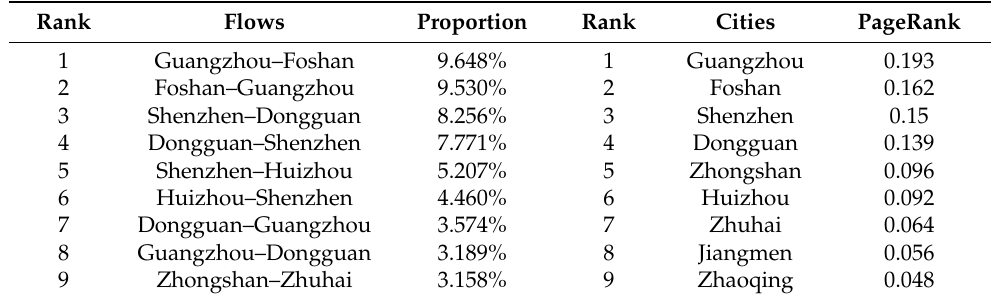
Table 2. Results of complex network analysis of GBA. Rank Flows